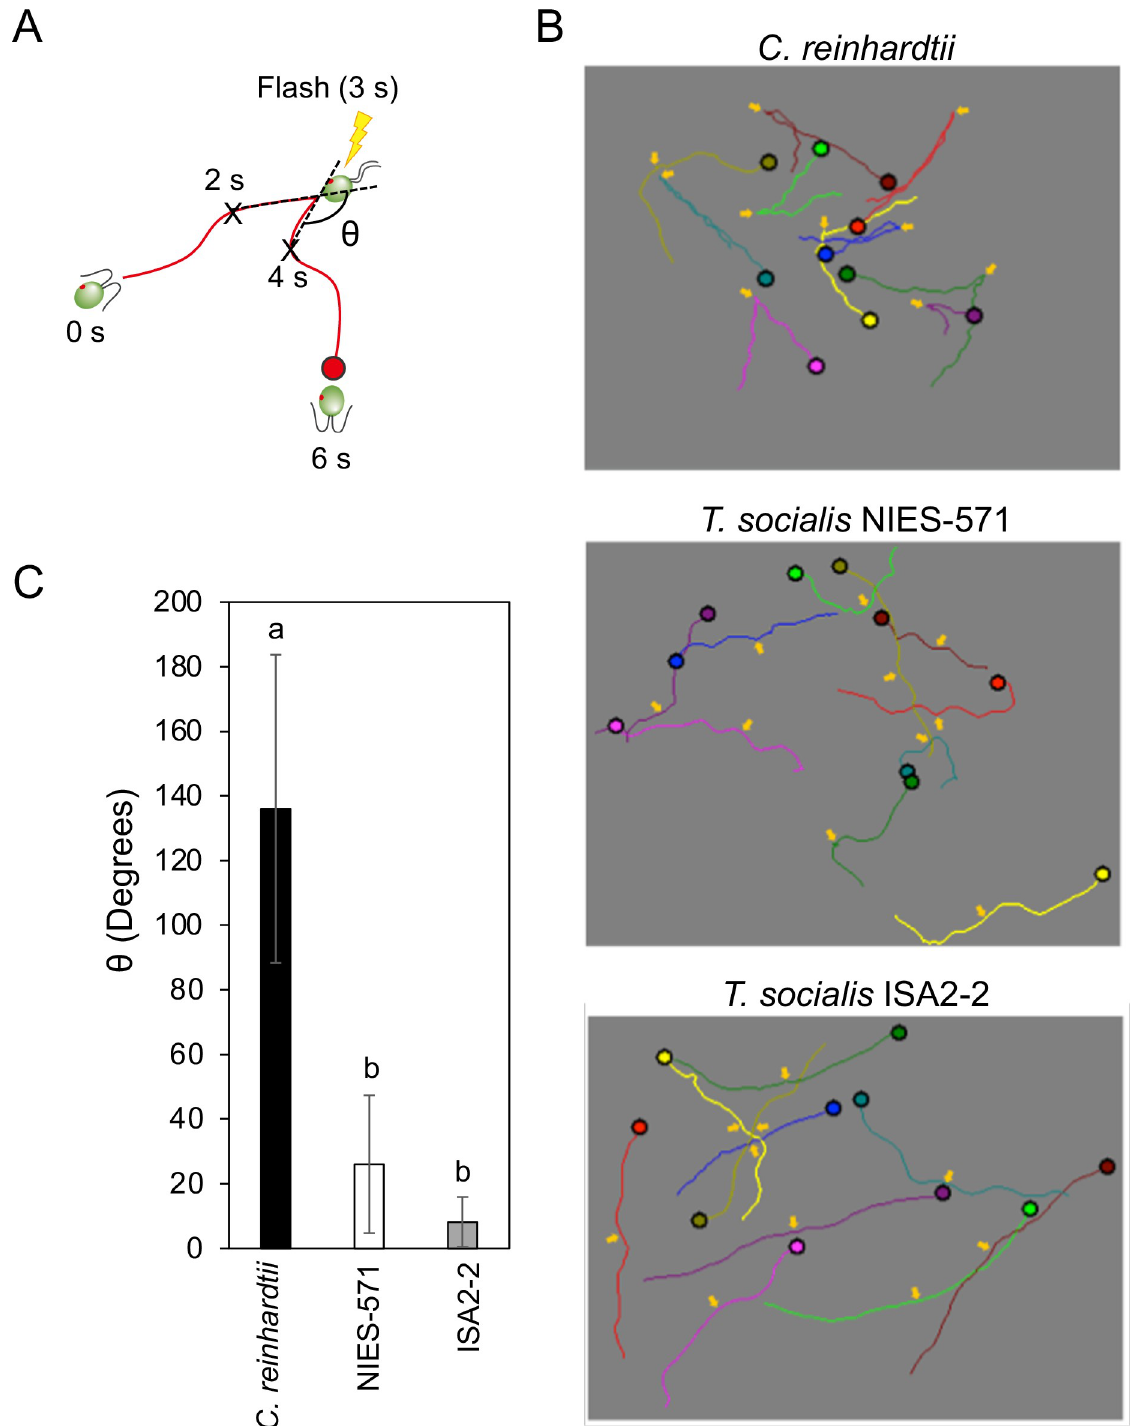
Fig 3. Tetrabaena socialis did not exhibit a photoshock response. (A) Schematic image of the photoshock response in C . reinhardtii . After a flash illumination, C . reinhardtii cells change their ciliary waveform, swimming backward for a short period before returning to their normal swimming pattern. Trajectories for 6 s were traced before and after a flash illumination, and the angle ( θ ) between trajectories before and after the flash illumination for 1-s each was measured. (B) Representative 6-s swimming trajectories of wild-type C . reinhardtii cells and T . socialis NIES-571 and ISA2-2 colonies. Different colors indicate different cell trajectories. The yellow arrows indicate the flashlight illumination point. (C) The angles between trajectories before and after the flash illumination. Means ± S.D. (n = 10 cells/colonies) are shown. Different letters indicate significant differences ( p < 0.01, one-way ANOVA and Tukey honest significance difference [HSD]).